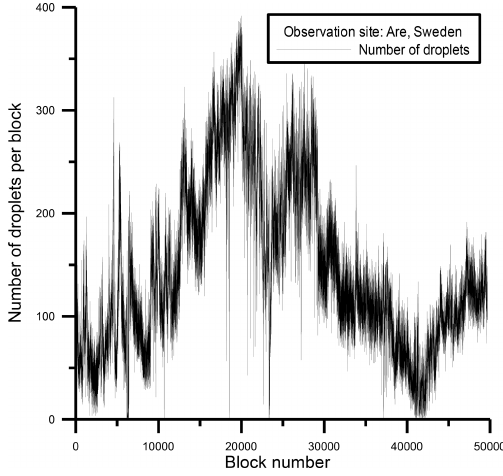
Figure 6. Time series of the number of droplets per block, sampled at a hilltop in Are,